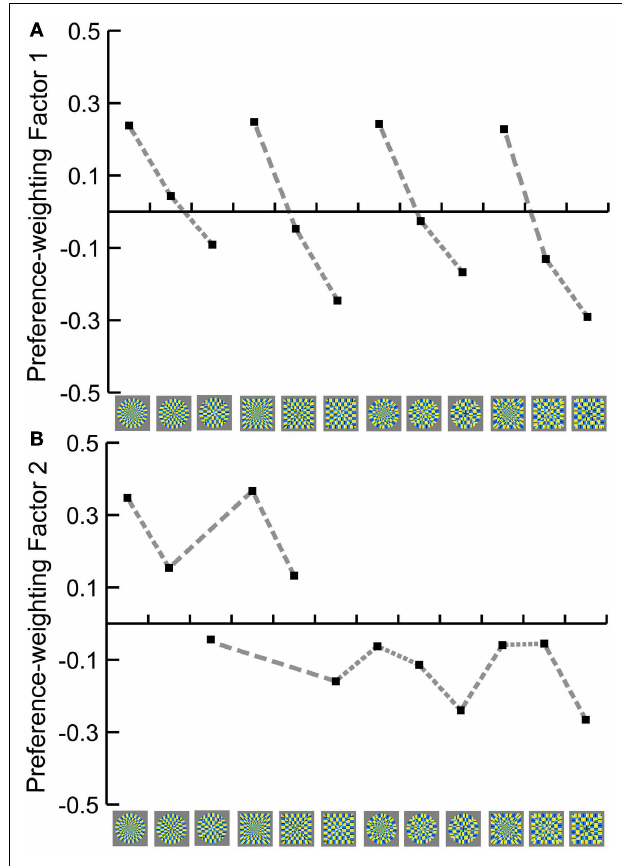
FIGURE 8 | Summary preference functions for (A) Factor 1 (radial, elliptic, and paraboloidal layout) and (B) Factor 2 (illusion). The functions were calculated from the preference functions of all 30 participants, weighted by their loadings on the Q -mode factors, and then